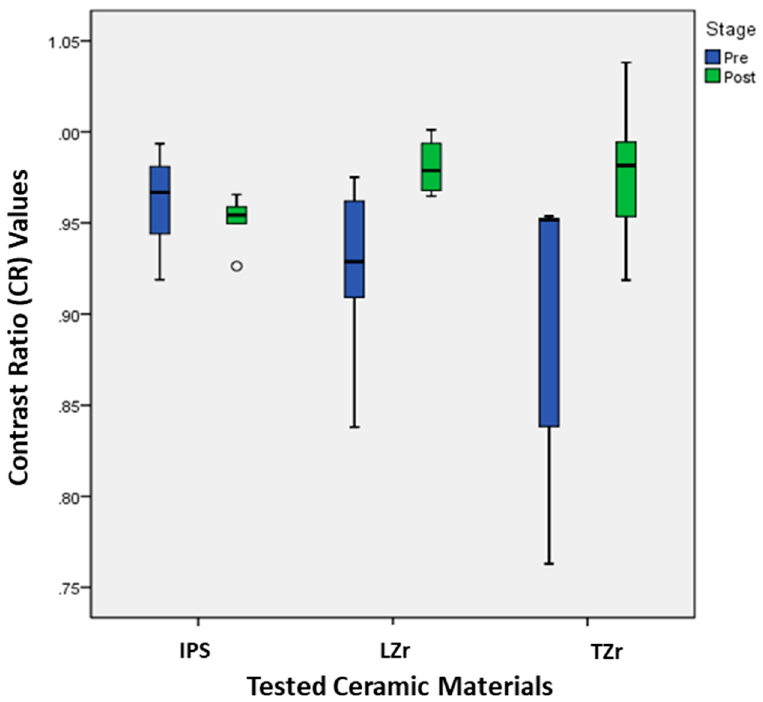
Figure 4. Comparison between the pre- and post-bleaching values of contrast ratio (CR) for the three tested materials (IPS, LZr, and TZr).